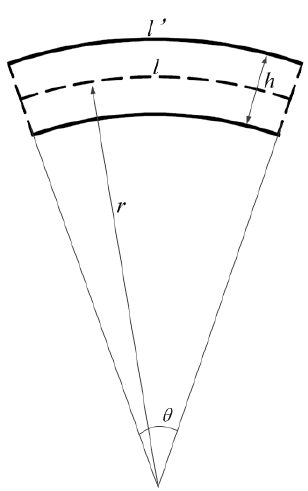
Figure 3. The schematic of the FBG strain sensor under pure bending.